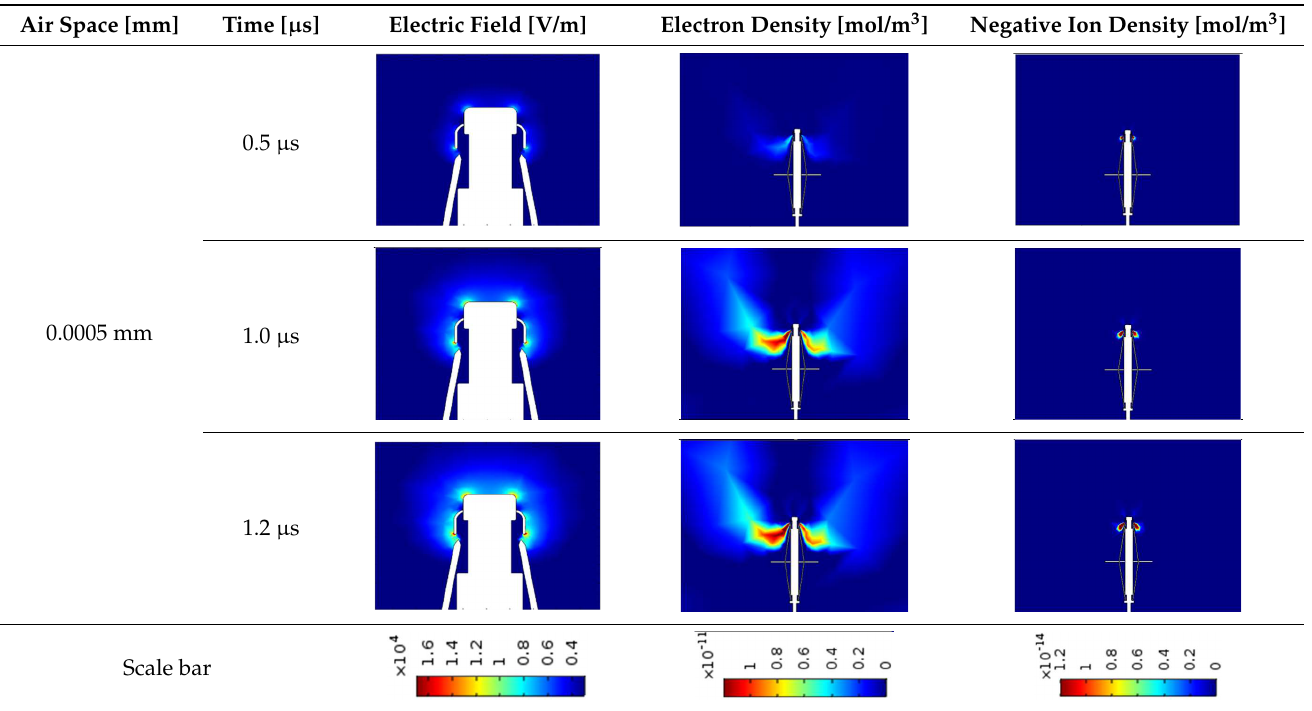
Table 3. The electric field distribution, free electron density, and negative ion density as a function of time steps.